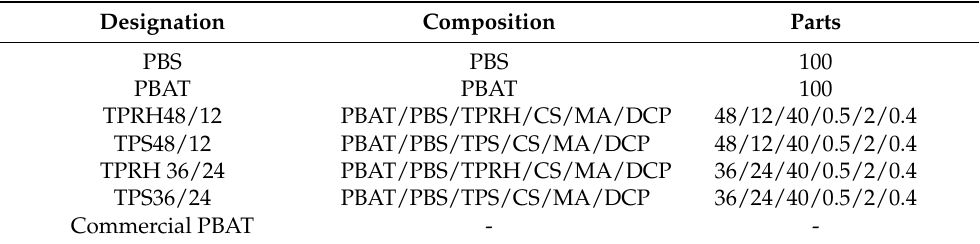
Table 2. The compositions of the PBAT/PBS/TPS and PBAT/PBS/TPRH for the fabrication of biodegradable polymers. Designation